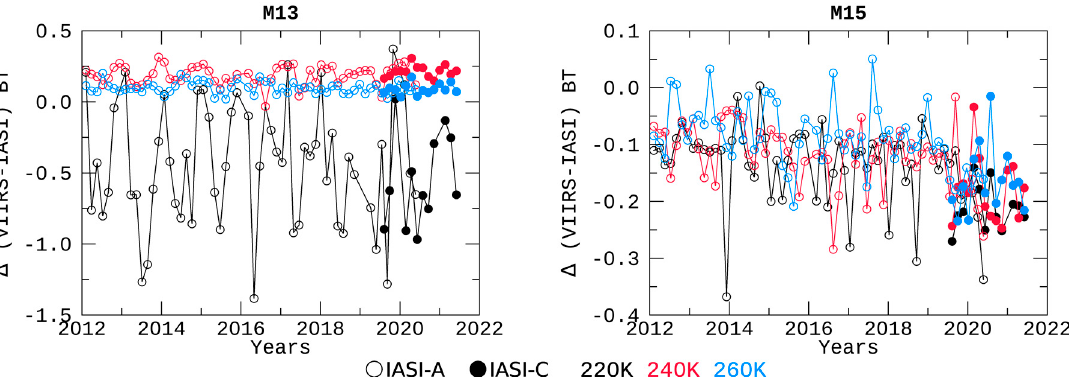
Figure 13. S-NPP VIIRS-IASI BT difference ( Δ BT) time series for bands M13 and M15 at IASI-simulated M15 BT centered at 220 K, 240 K, and 260 K (described by different colors) with bin sizes of ±5 K. Empty symbols define IASI-A, while filled symbols represent IASI-C. Brightness temperature units are in Kelvin. Table 6. Average Δ BT between SNPP VIIRS and IASI-A/C at different BT levels. All units are in Kelvin.